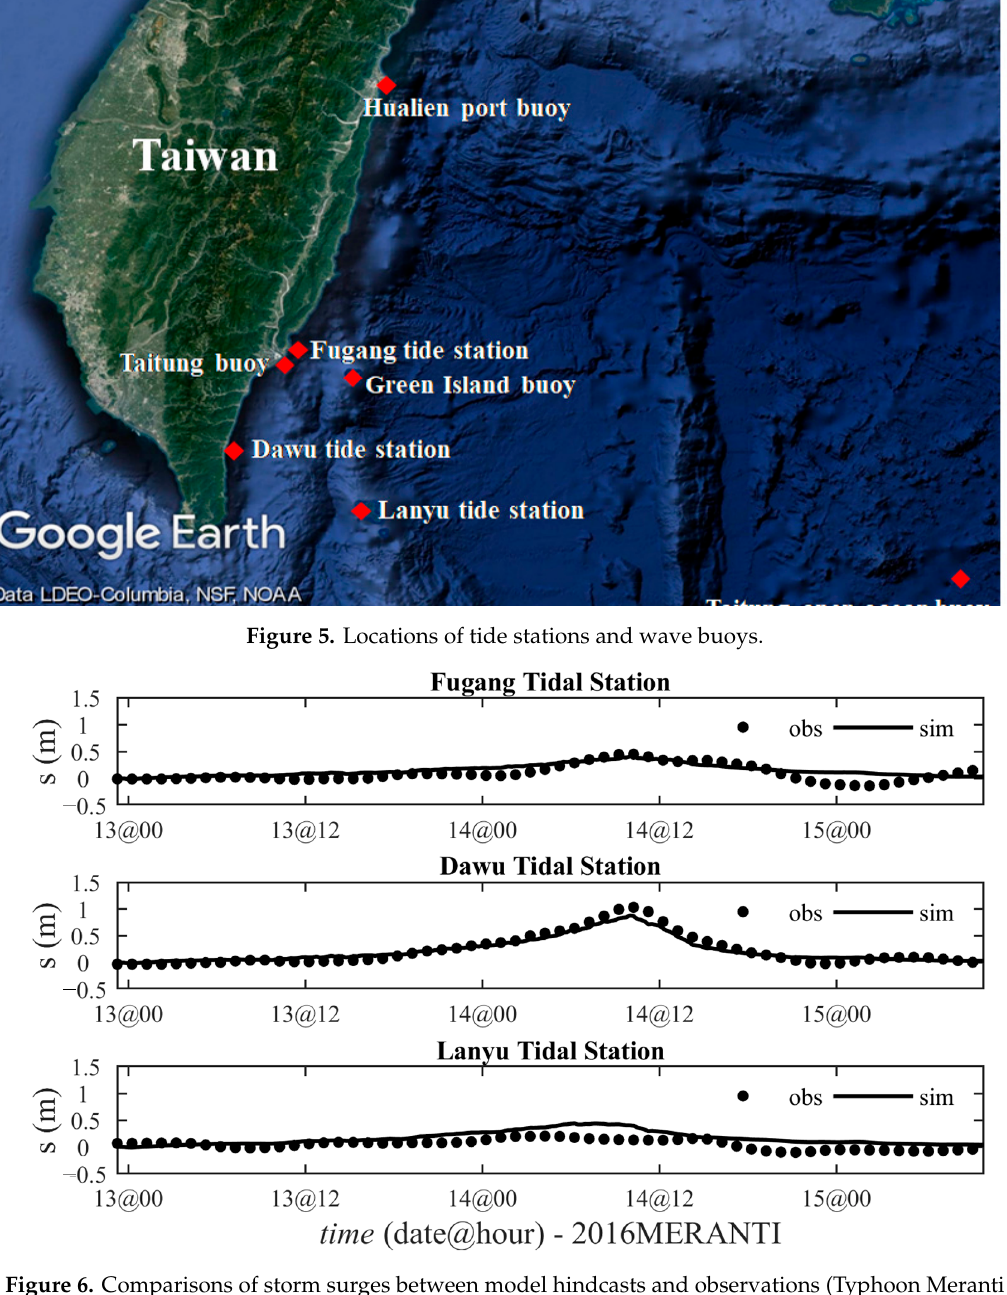
Figure 7. Comparisons of significant wave heights between model hindcasts and observations (Typhoon Meranti September 2017). Refer to Figure 5 for observation site locations.